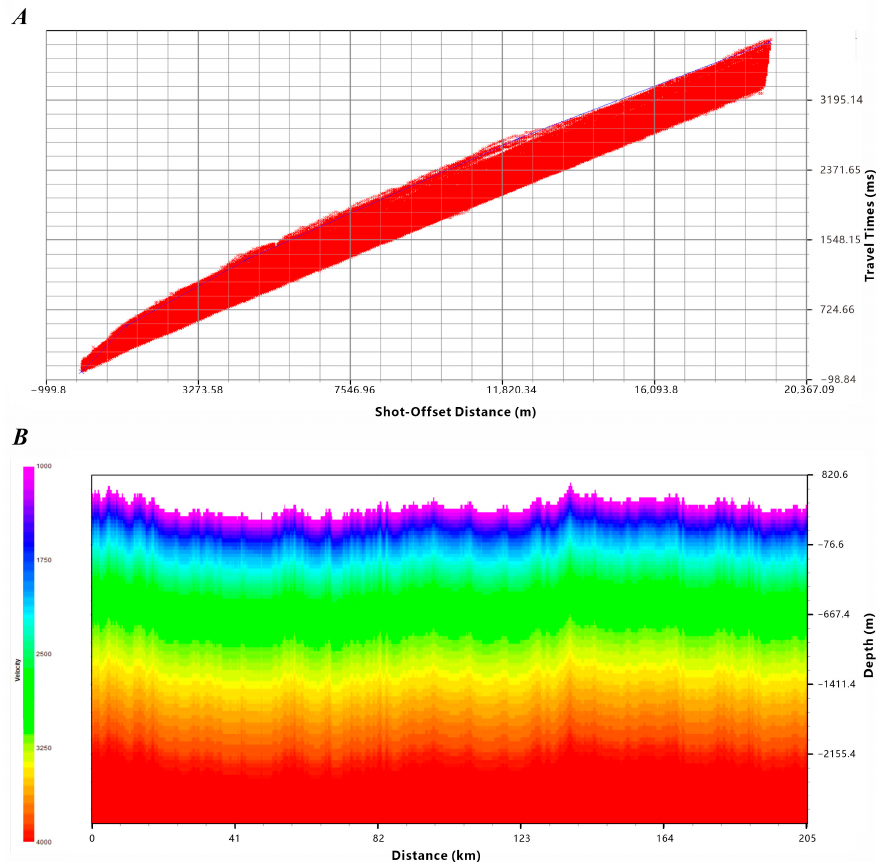
Figure 5. ( A ) Results of the conversion of coordinates of the deep seismic profile (shot ‐ receiver distance and time). ( B ) Initial model.